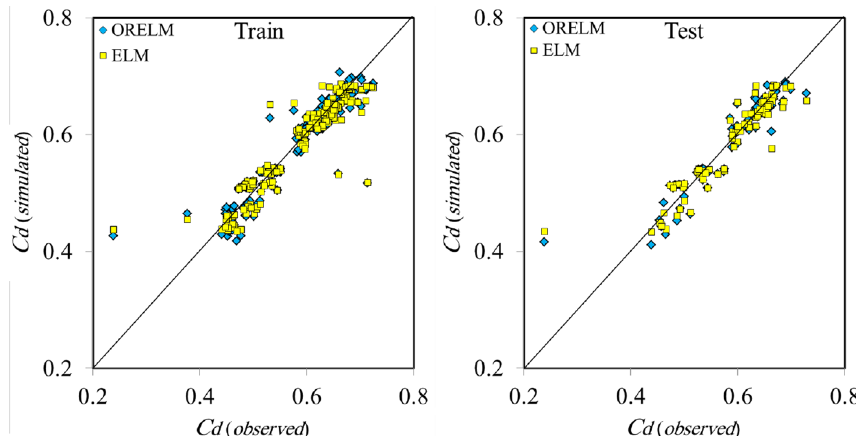
Fig. 12 Scatter plots of ORELM and ELM models in both modes